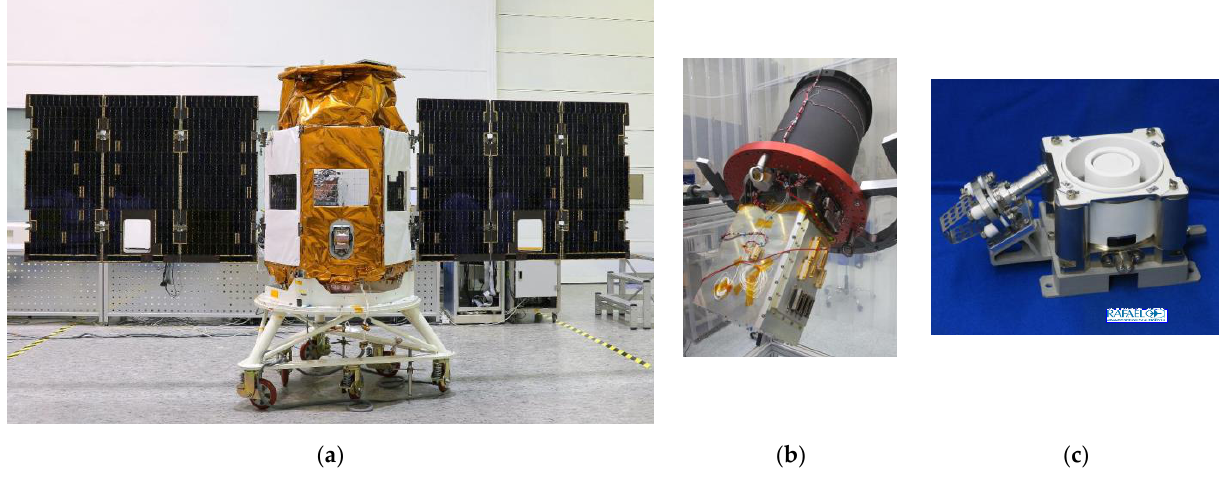
Figure 1. ( a ) VEN μ S satellite; ( b ) VEN μ S radiometer; ( c ) IHET. During VM01 phase, VEN μ S satellite was on a low earth orbit at 720 km. This orbit was sun synchronous with an inclination of 98.27 ◦ , crossing the equator at 10:30 local